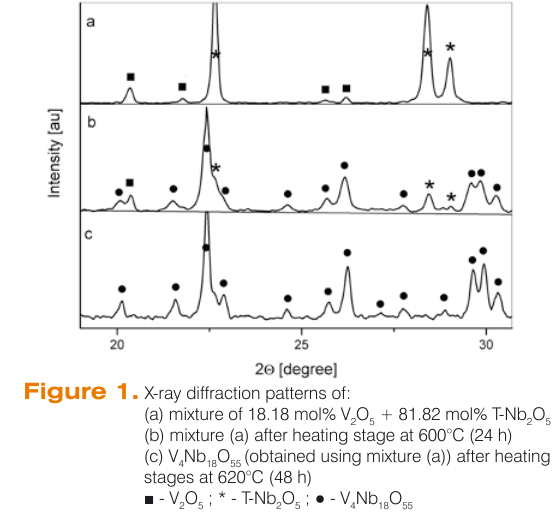
O + 81.82 mol% T-Nb 2 5